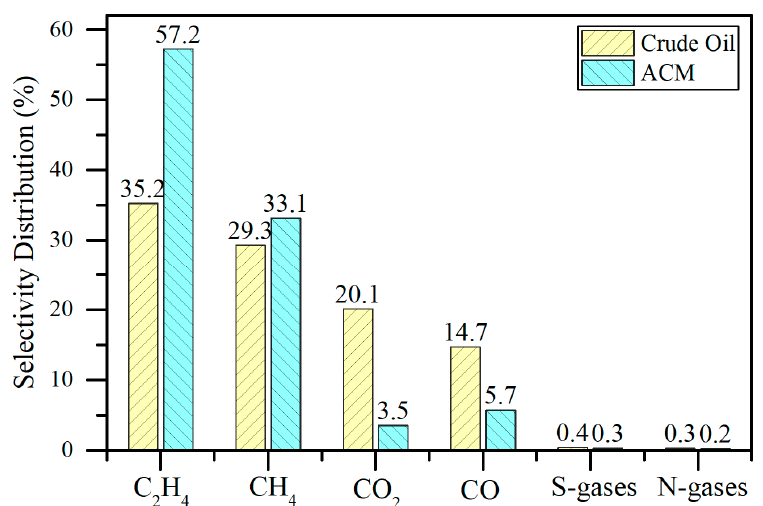
Figure 13. Selectivity distribution of gaseous products released from pyrolysis of crude oil in the presence and absence of activated carbon modified with 5.0 wt.% of magnetite nanoparticles (ACM).